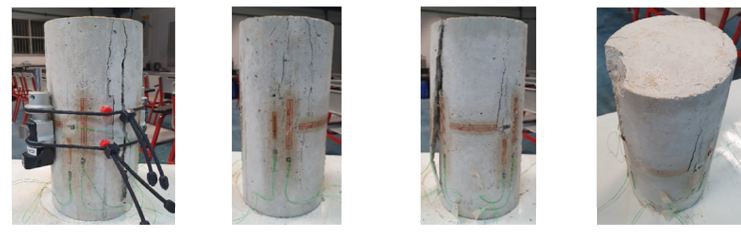
Figure 4. Typical specimen-failure schemes.